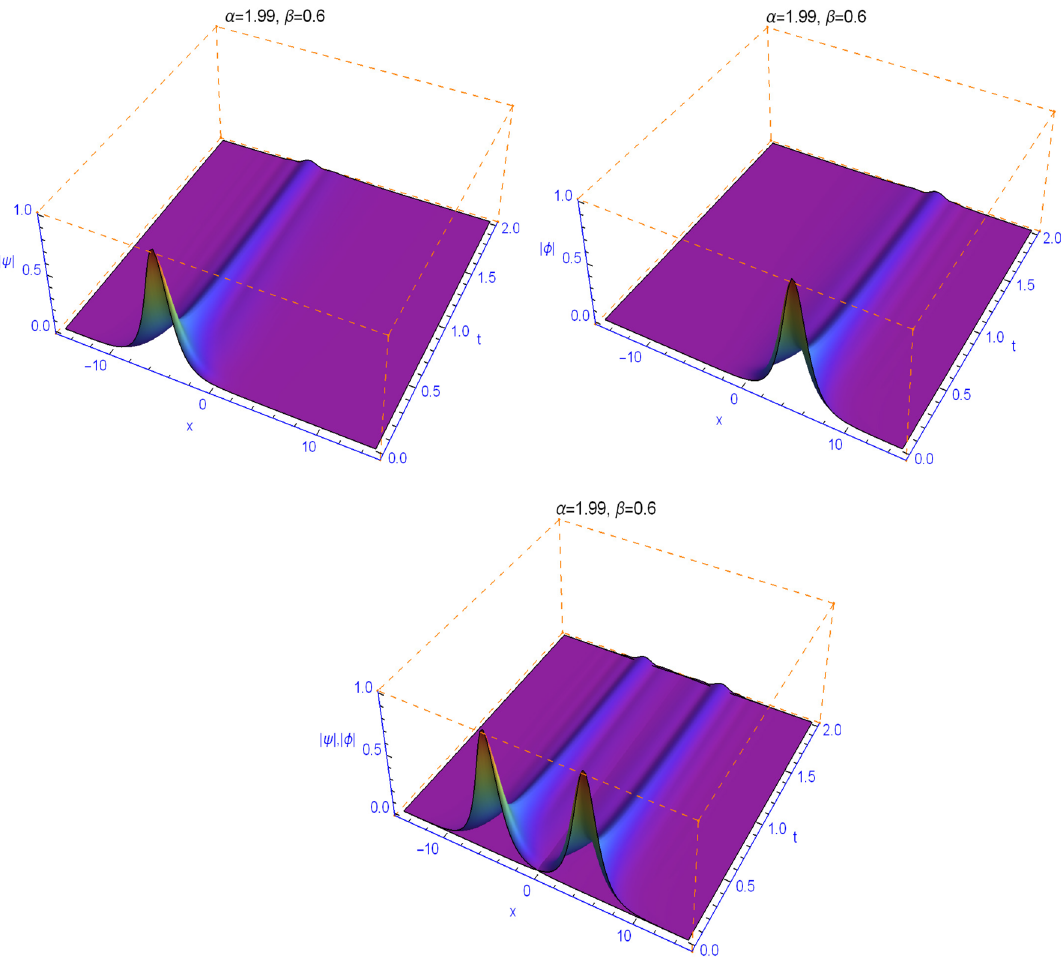
Figure 4. Plots of model (36) for β = 0.6 and α = 1.99